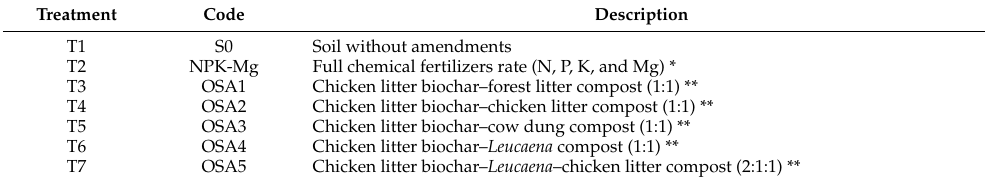
Table 1. Codes and description of the treatments used in the field